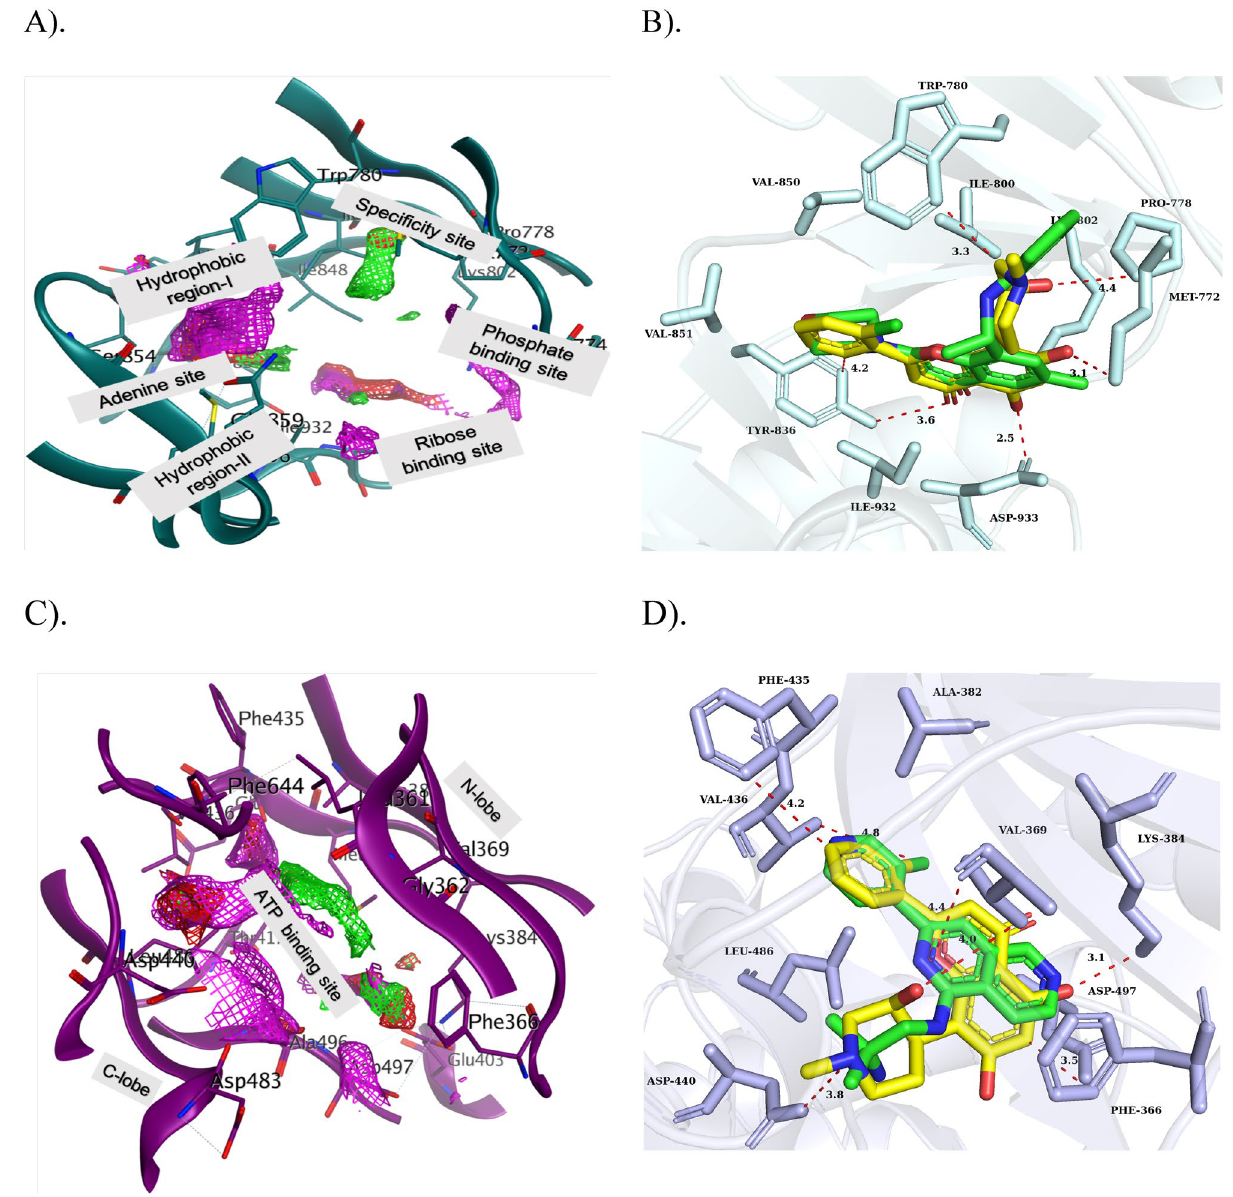
Figure 2. (A) 3D position of the sub-pocket in the ATP binding site of PI3K-α and (B) Overlays of bound crystal ligand PIK-108 (green) and flavopiridol (yellow) at the ATP binding site of PI3K-α. (C) . PKC-η is rendering ATP binding site with interaction potential including residues and (D) Overlays of bound crystal ligand naphthyridine (green) and flavopiridol (yellow) at the ATP binding site of the PKC-η. The proteins are shown in the cartoon and the key residues in the binding cavity indicate the sticks with labeling. Binding interactions are indicated in red dotted lines with distances (Å). (red: ligand exposure, green: hydrophobic, blue: